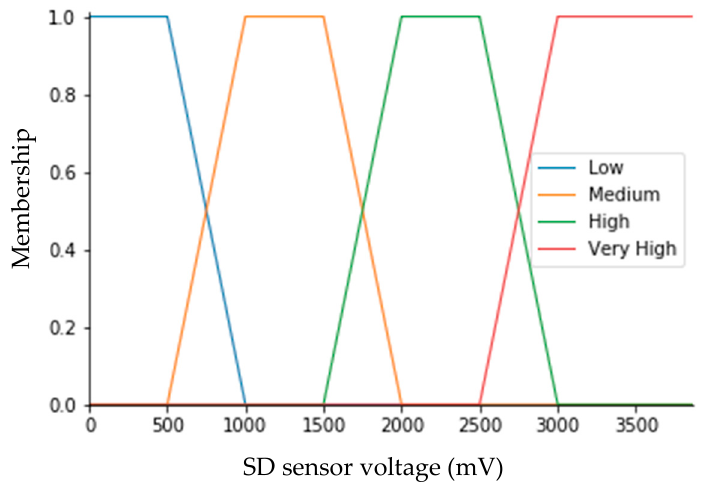
Figure 9. Membership functions for sunshine duration (SD) sensor voltage.